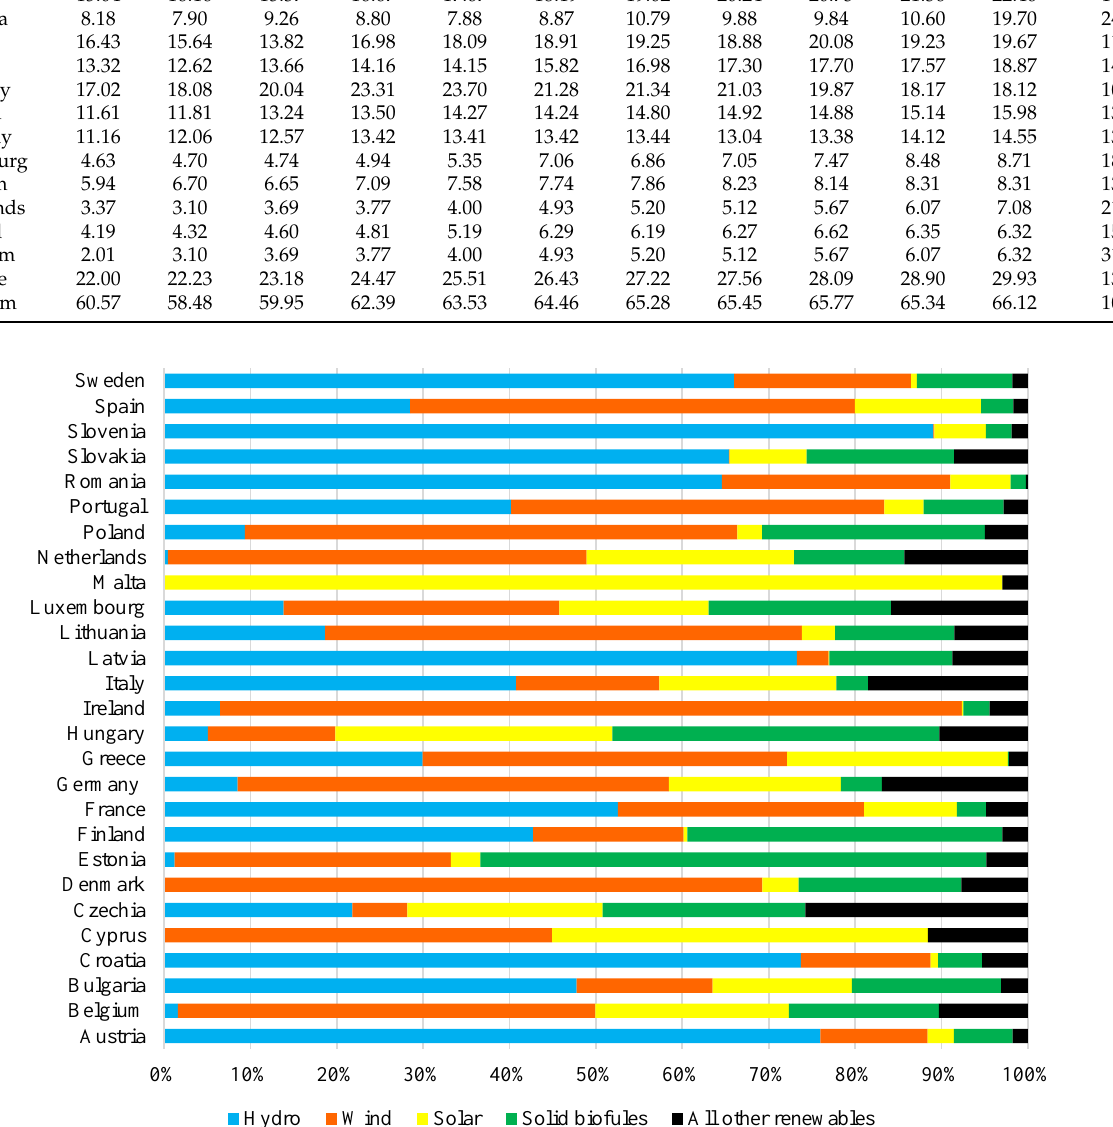
Figure 2. Structure of renewable energy use in EU countries in 2019.